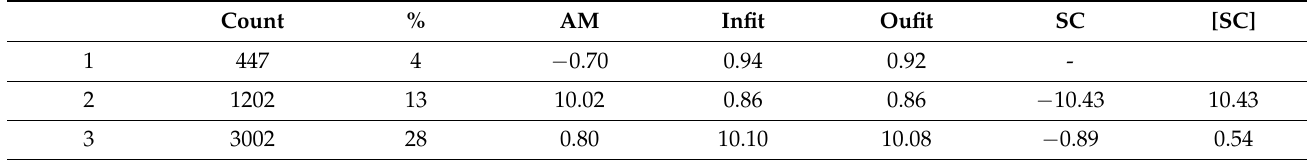
Table 6. Verification of the 3-point Likert scale’s appropriateness.